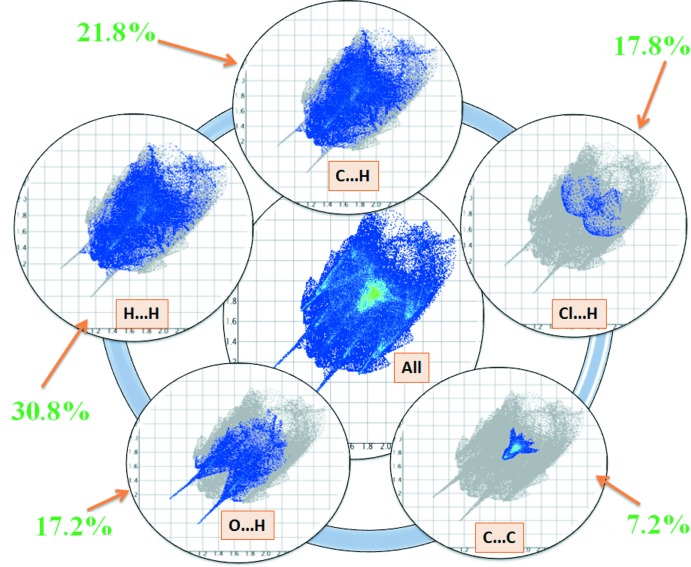
Two-dimensional fingerprint plots with dnorm views of all, the H⋯H, O⋯H/H⋯O, C⋯H/H⋯C and N⋯H/H⋯N contacts in the title compound.